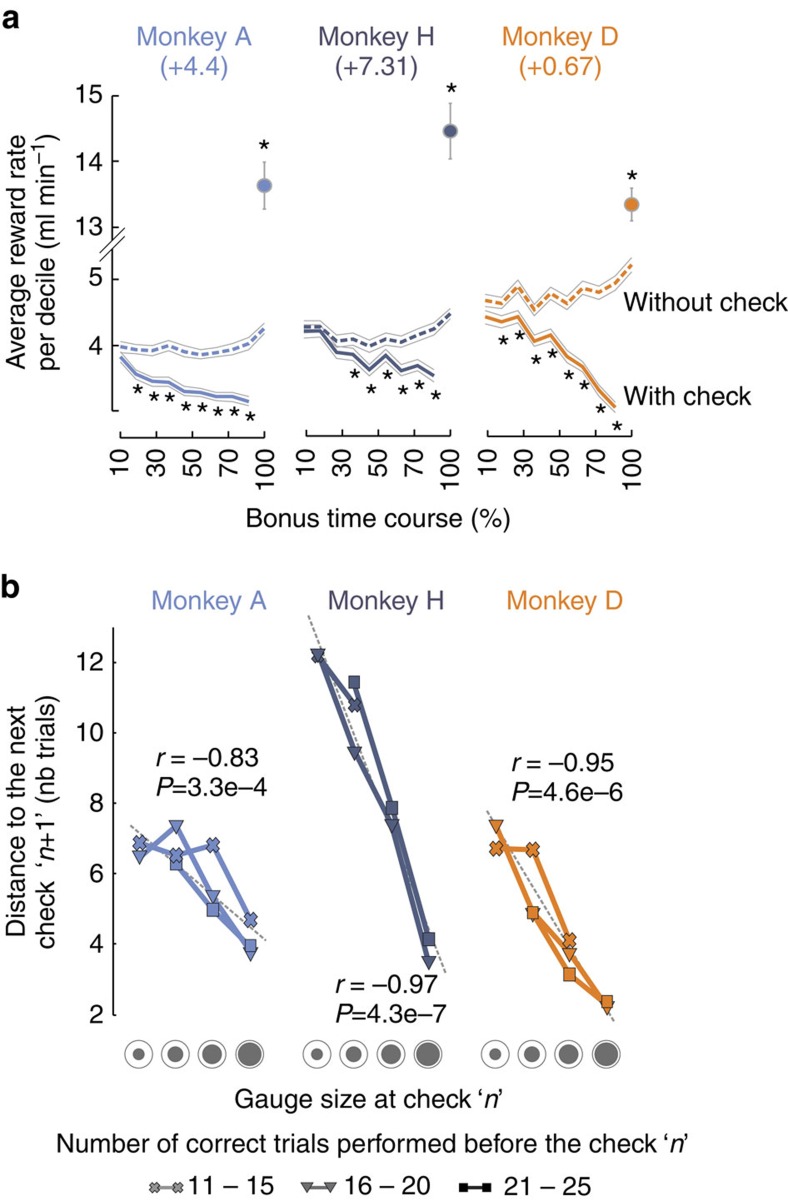
Effects of checking.(a) Evolution of average reward rate during a block. Solid lines show for each monkey the average amount of reward per minute obtained during a block (condition: ‘With check'). Each block was divided in ten successive time bins covering several trials. The evolution is expressed in per cent of total time in a block. The single point at 100% corresponds to the last decile that includes the bonus reward. Data can be compared with a hypothetical but ideal case where the animal does not check by excluding the time spent in checking the gauge size (dashed lines, condition ‘Without check'). The number in parenthesis is the difference in cumulated reward rates between the two conditions (‘With check' versus ‘Without check'). It reveals an overall positive gain for all monkeys. (b) Effect of observed gauge size on checking. The plots show for each monkey the number of trials (distance) that the animal takes before a check n+1 after having seen a particular gauge size (x axis) at check n. The larger the gauge size seen at check n, the smaller the number of trials (distance to check) before the next check n+1. The effect is independent of the number of trials performed in the main task in the current block (symbols), that is, independent of time. This suggests that monkeys properly used information gathered from the gauge size to regulate checking. Correlations displayed on graph were made on the three sets of data.